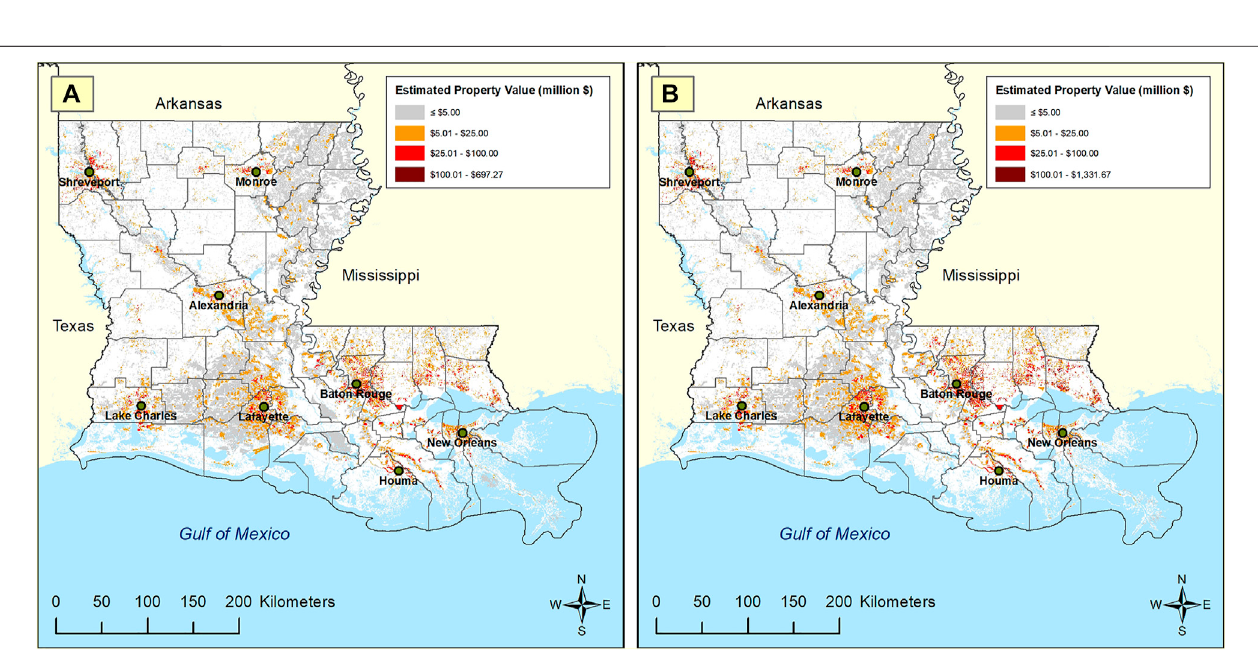
FIGURE 4 | Estimated property value by census block (structure + content, 2010$): (A) 2010, and (B) 2050. Historical (Present) and Projected Property Loss.